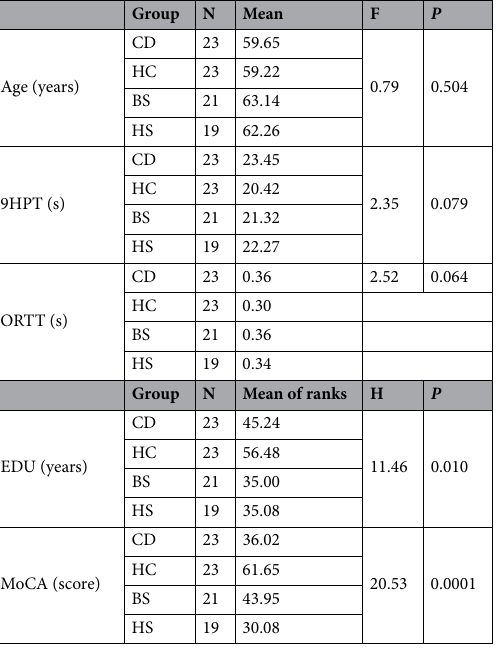
Table 1. Summary of demographic and clinical assessments. CD: cervical dystonia, HC: healthy control, BS: blepharospasm, HS: hemifacial spasm, n: number, 9HPT: 9-hole-peg-test, ORTT: online reaction time test, EDU: education level, MoCA: Montreal Cognitive